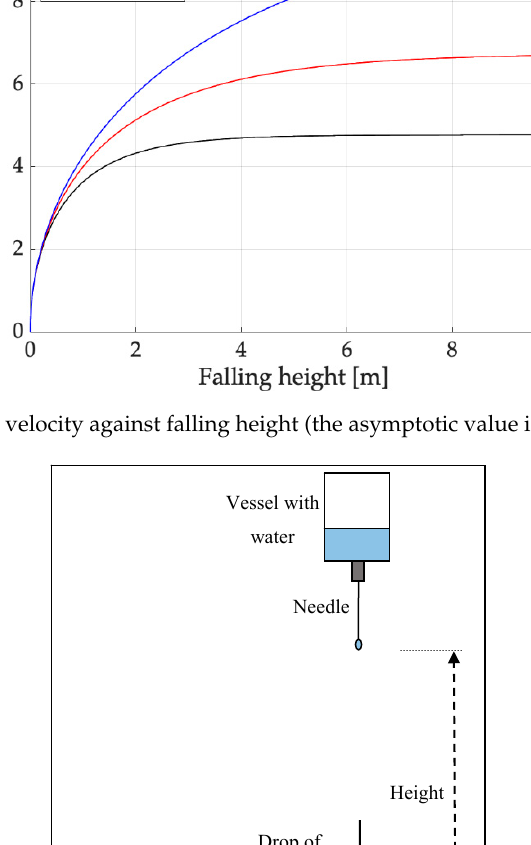
Figure 9. Raindrop velocity against falling height (the asymptotic value is the limit velocity). Figure 8. Raindrops collected on a plastic sheet.